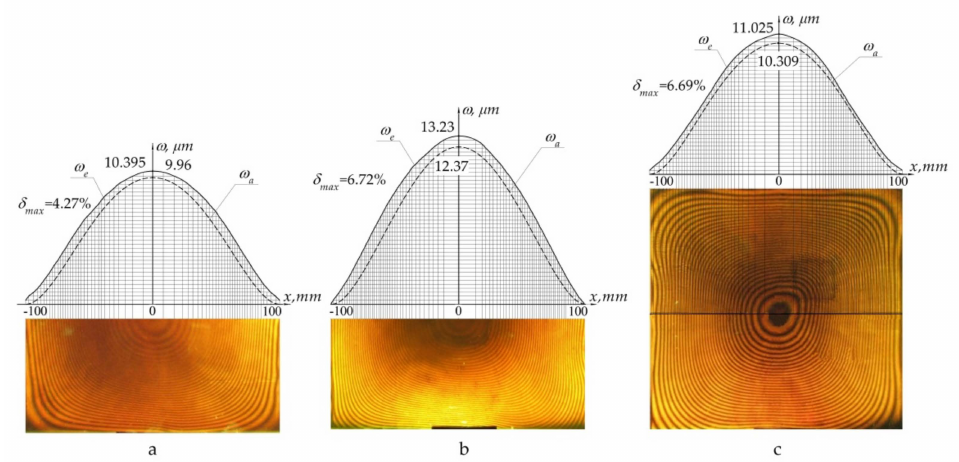
Figure 13. Deflection under the action of distributed pressure p of intact panel ( a ); panel with a notch in the centre ( b ); panel with off–centre notch ( c ): ω e —experimental distribution; ω a —theoretical (analytical) distribution; δ max —maximum relative